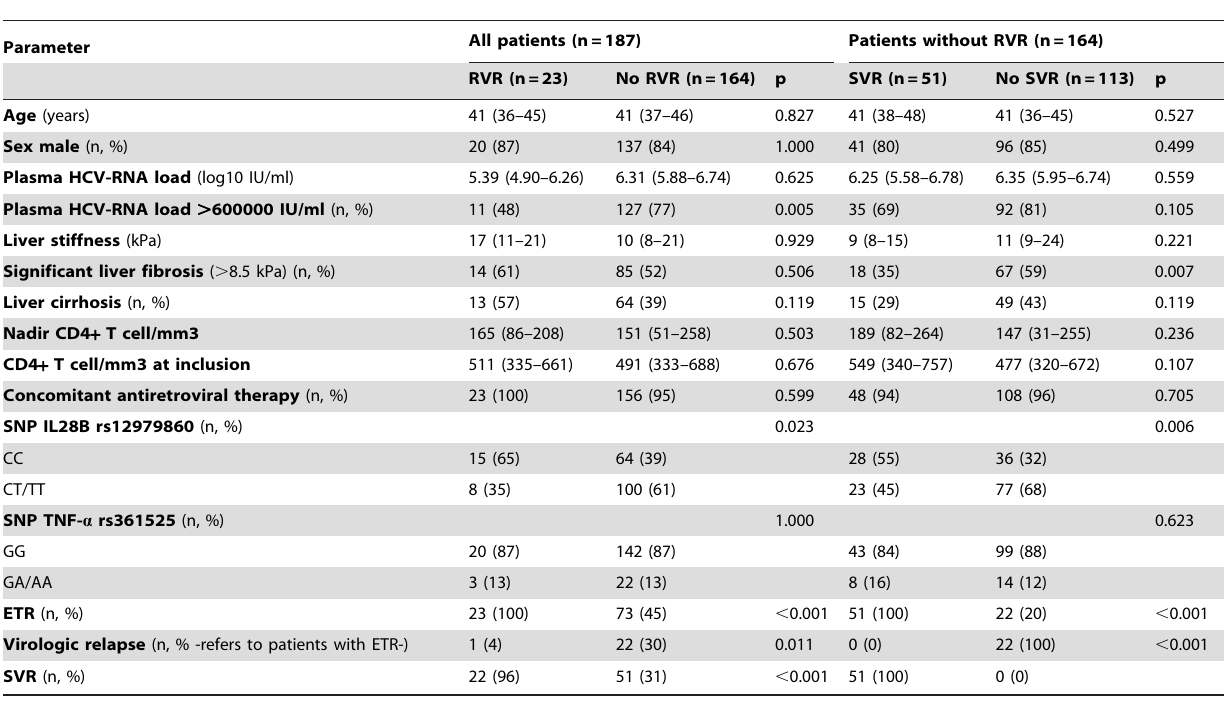
Table 3. Characteristics of HIV-infected patients coinfected by HCV genotype 1 treated with pegylated interferon alpha 2a plus ribavirin (n=187), grouped as a function of the presence or absence of rapid virological response.